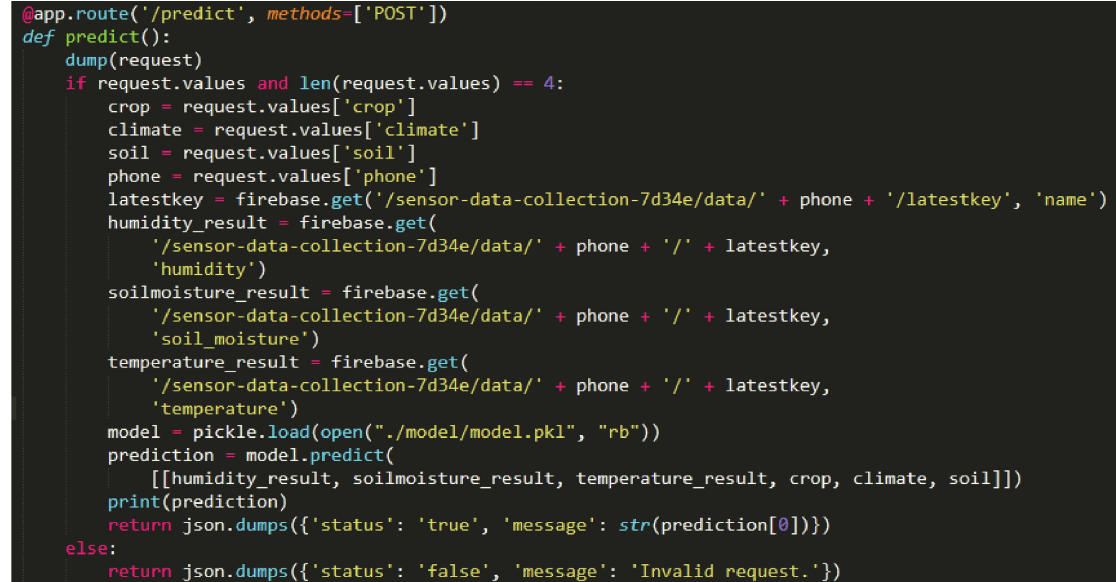
Figure 12: Data transfer from edge server to IoT server with prediction results.